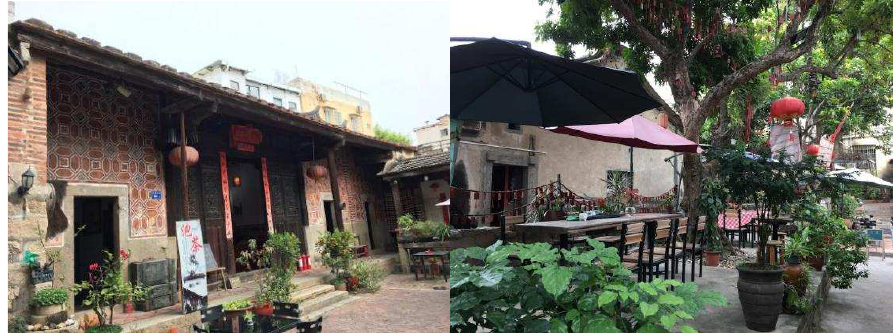
Figure 8. Traditional residential buildings converted into leisure spaces. Source: Taken by the authors.